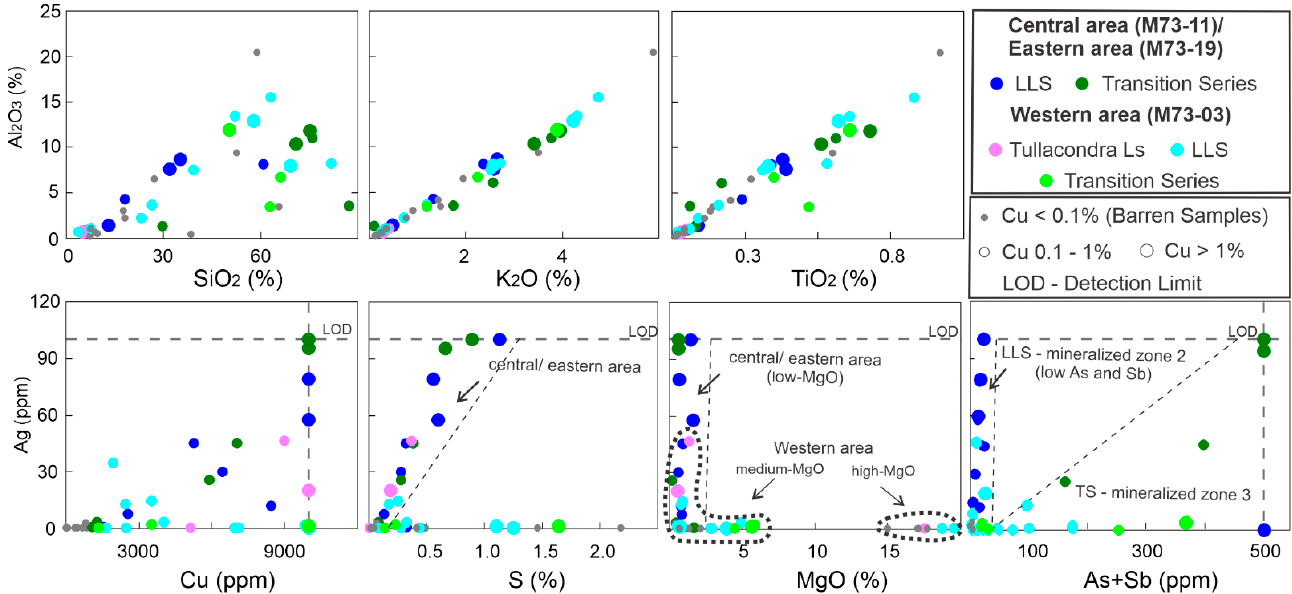
Figure 10. Bivariate plots showing the positive correlation between Al 2 O 3 and other major elements (SiO 2 , K 2 O, Al 2 O 3 , TiO 2 ) and Ag versus Cu, S, MgO, and As+Sb in different mineralized and barren host rocks (from the western, central, and eastern areas).